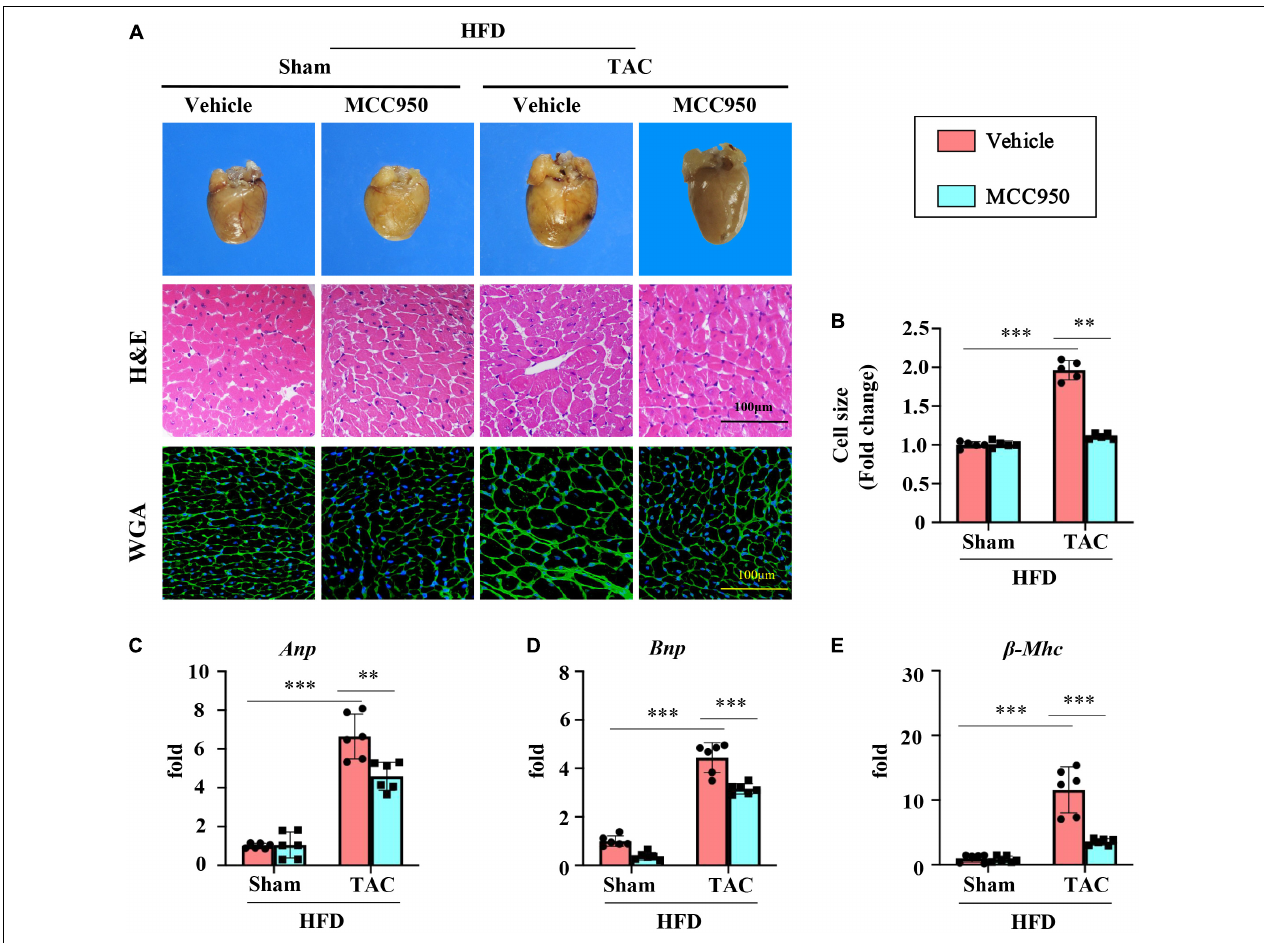
FIGURE 2 | MCC950 alleviated pressure overload-induced cardiac hypertrophy. (A) Representative photographs presenting morphology of the hearts, representative images of hematoxylin-eosin (H&E), and WGA staining for the determination of cardiomyocyte cell size, n = 5. (B) Cardiac hypertrophy was quantified by measuring the cross-sectional cell-surface area of cardiomyocyte from WGA staining, n = 5. (C–E) Q-PCR to measure mRNA expression of ANP, BNP, and β -MHC, respectively; n = 6. H&E, hematoxylin-eosin; WGA, wheat germ agglutinin; ANP, atrial natriuretic peptide; BNP, brain natriuretic peptide; β -MHC, β -myosin heavy chain. ∗ p < 0.05, ∗∗ p < 0.01, ∗∗∗ p <